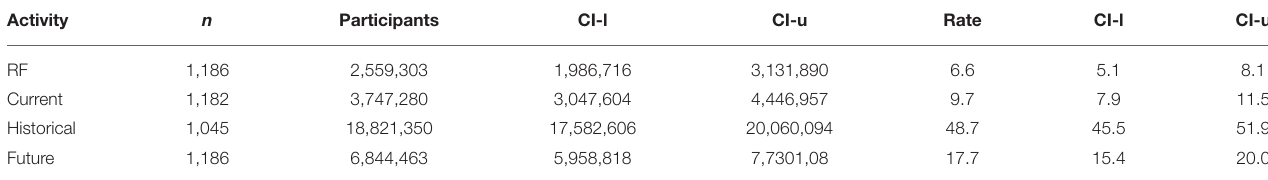
TABLE 1 | Nationwide population-based participation rates (%) in recreational fishing (RF, people who have fished and have the intention to fish in the next 12 months), current fishers (current, people who have fished at least once in the last 12 months), historical fishers (historical, people who have fished at least once in their life), and future recreational fishers (Future, people who have the intention to fish in the next 12